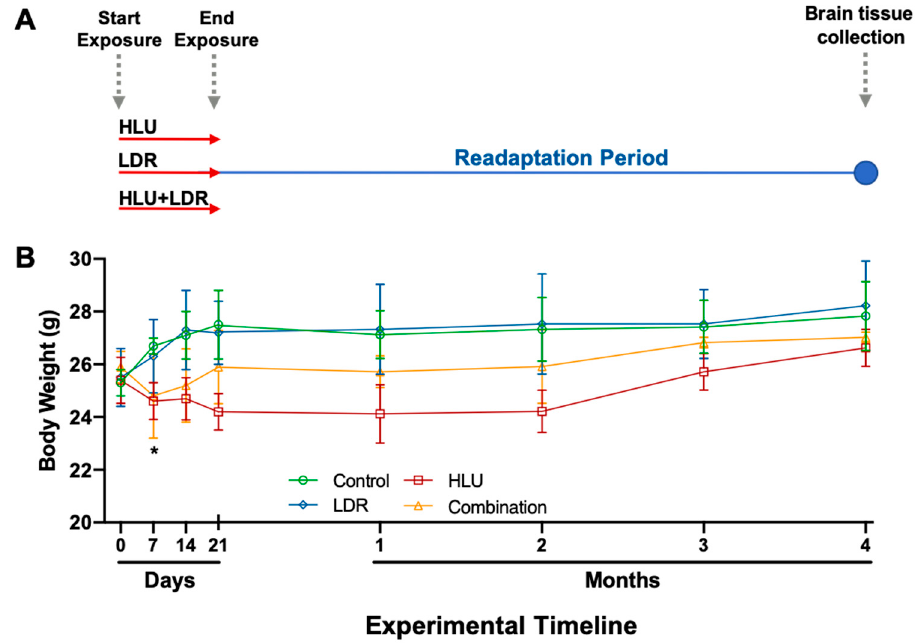
Figure 1. Experimental timeline and body weights during- and post-hindlimb unloading (HLU), low-dose irradiation (LDR) or combined HLU + LDR. ( A ) Whole brains were isolated from C57BL / 6J at 4 months post-experimental conditions of hindlimb unloading (HLU, 21 days), low-dose irradiation (LDR, 0.04 Gy for 21 days) or combined LDR and HLU timeline. ( B ) Body weights were monitored throughout the experiment (21 days) and during readaptation (4 months post-experimental exposure). Baseline weights were taken on day 0, prior to the initiation of HLU and LDR exposure. An unpaired t -test with Welch’s correction compared experimental groups with controls. A * denotes significance of HLU only compared to controls at the 7-day timepoint. Error bars denote standard error of means. Dashed gray arrows highlight start and endpoints of experimental LDR and HLU treatments, and the final timepoint of the experiment when tissue was collected for transcriptomic analysis.